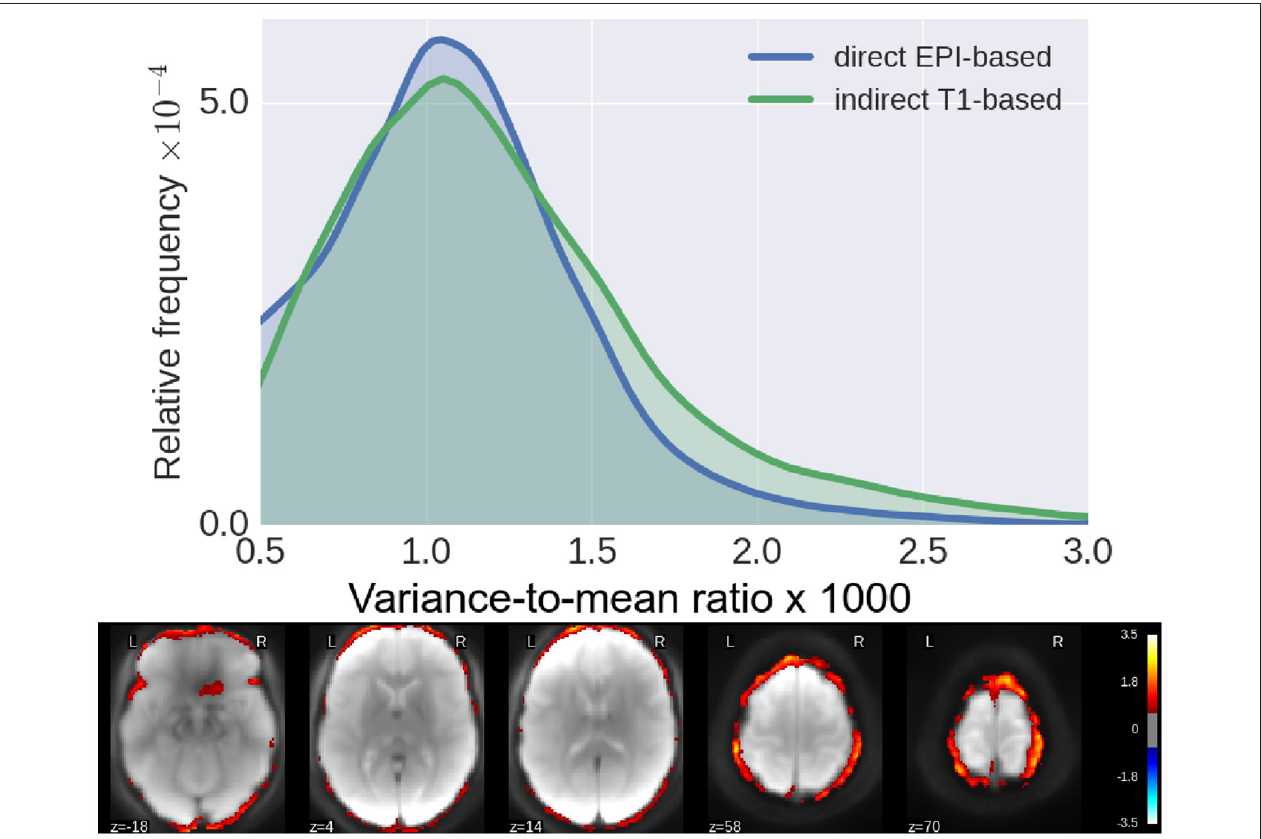
FIGURE 4 | Residual inter-subject variability after registration. (Top) Histograms of relative variance [smaller is better, refer to Equation (4) for definition] for both pipelines. We see that our proposed method reduces the inter-subject variability by a much larger margin, indicative of improved subject-to-subject alignment. (Bottom) Log10 of ratio of the relative variance for indirect T1-based pipeline/direct EPI-based. Again, we see clearly that the gain of our proposed method is most pronounced along the cortical surface.